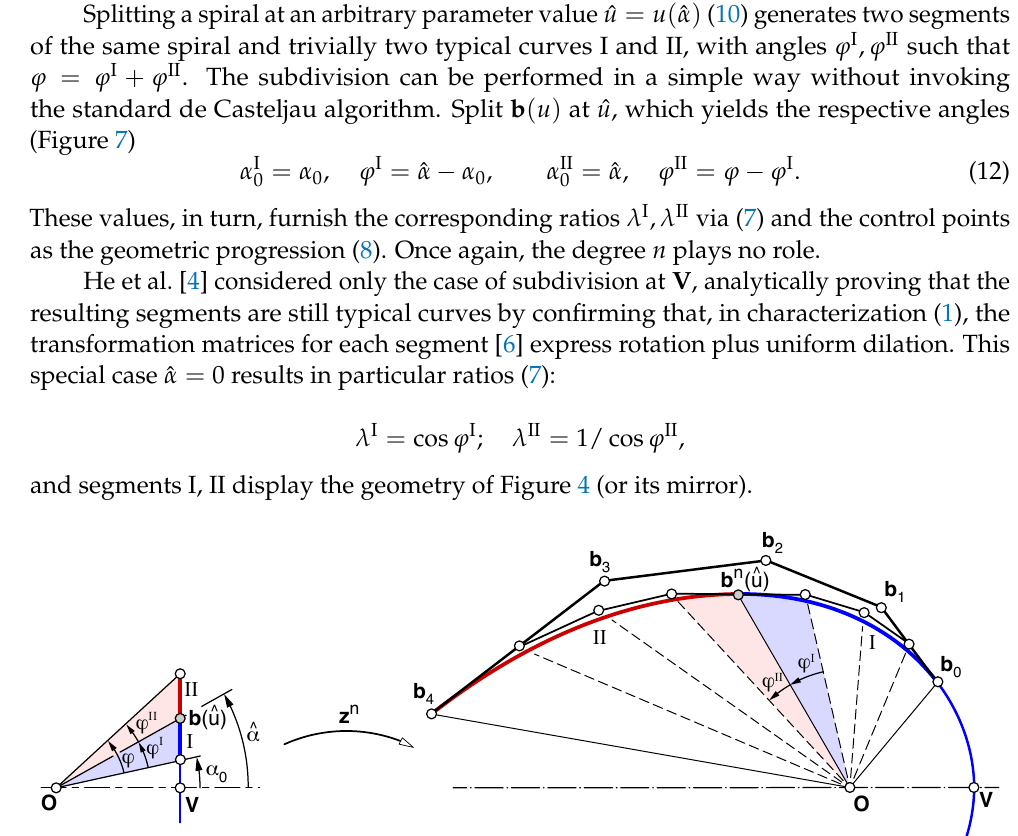
Figure 7. Subdividing a typical curve ( n = 4) at an arbitrary parameter value ˆ u = u ( ˆ α )